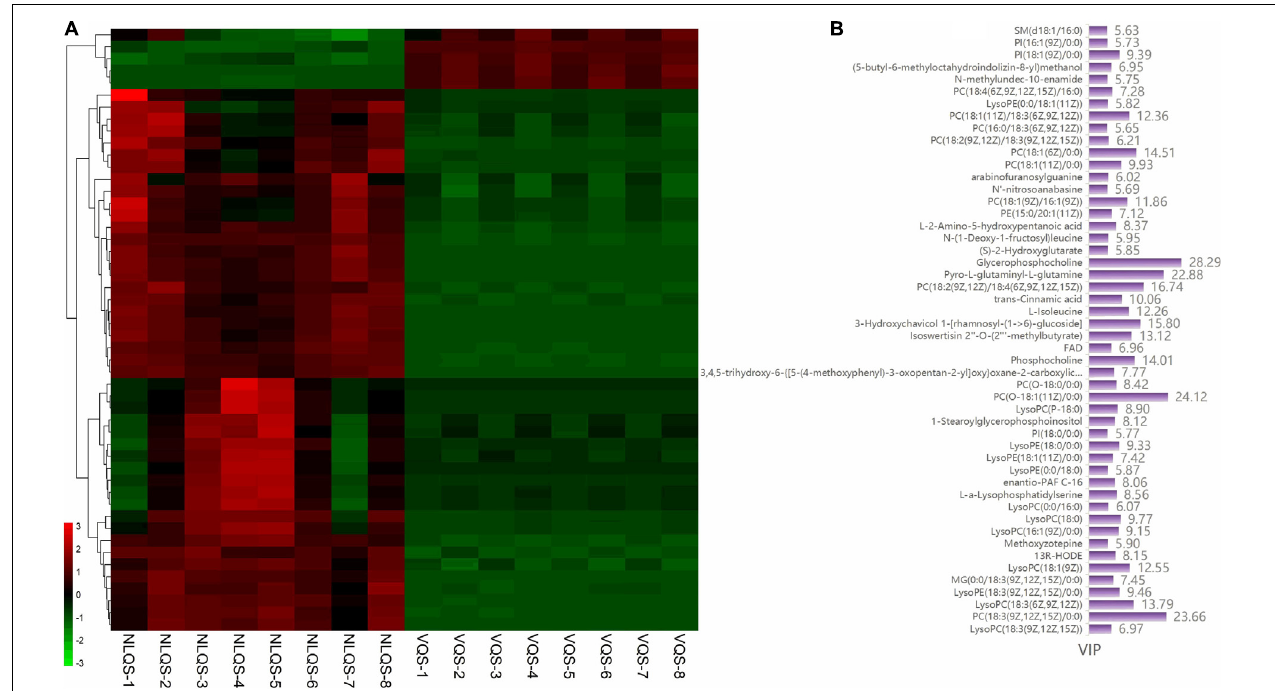
FIGURE 4 | Heat map of the hierarchical clustering analysis of the top 50 differentially expressed metabolites in the comparison of NLQS with VQS in the honeybee Apis mellifera . (A) Differentially expressed metabolites were separated using hierarchical clustering. The x-axis has the eight (1–8) biological replicates of each type of spermatheca, and the y-axis represents the differentially expressed metabolites separated using hierarchical clustering. The color from green to red indicates an increase in abundance of metabolites from low to high, respectively. (B) VIP values of each differentially expressed